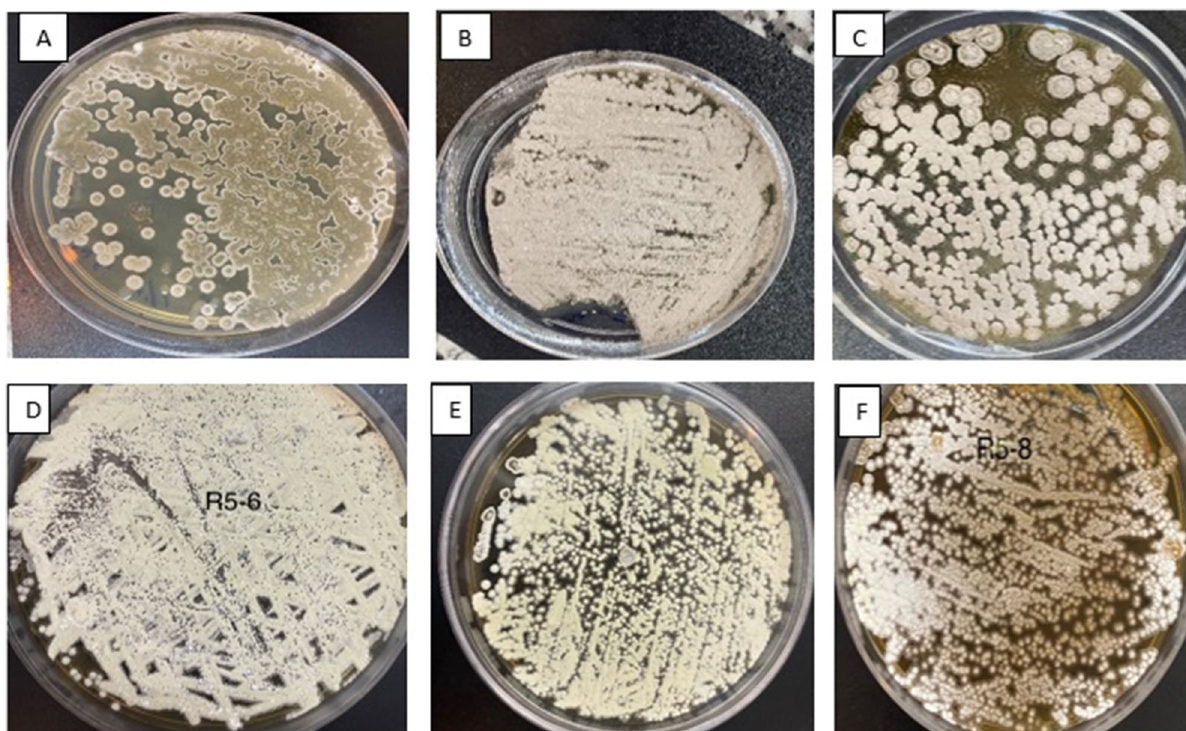
Figure 2. Morphological characteristics of six endophytic actinobacteria isolates from Luffa cylindrica , grown onto ISP2 after 2 weeks of incubation at 28 °C. KUMS-B1 isolate; cream–brown colony ( A ): KUMS-B2 isolate; grey–creamy watery colony ( B ) KUMS-B3 isolate; creamy-brownish colony ( C ): KUMS-B4 isolate; creamy–light yellowish colony ( D ): KUMS-C5 isolate; creamy–yellowish colony ( E ): KUMS-B6 isolate; small white–brownish colony ( F